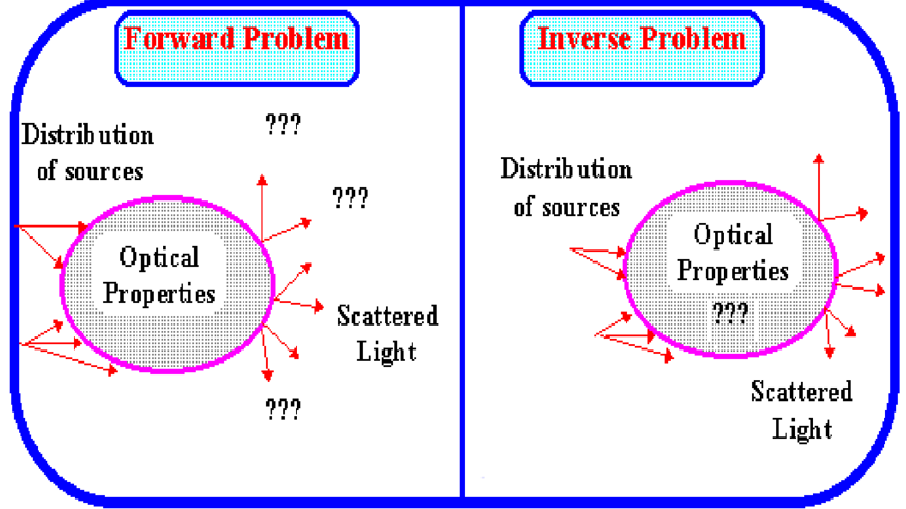
Figure 2. A graphical representation of the forward and inverse problems (adapted from Ref. [7]).